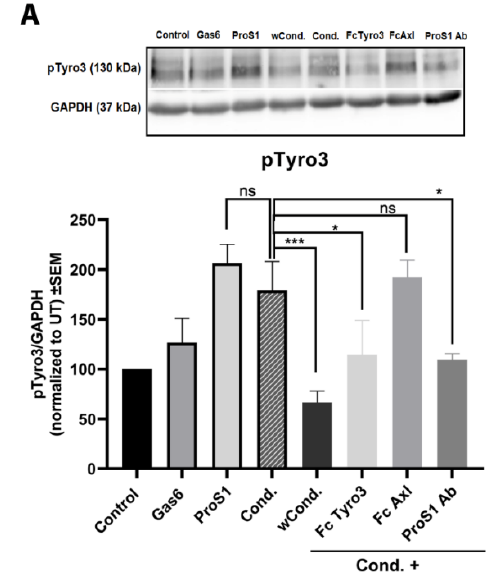
Figure 4. Cont . Figure 4.